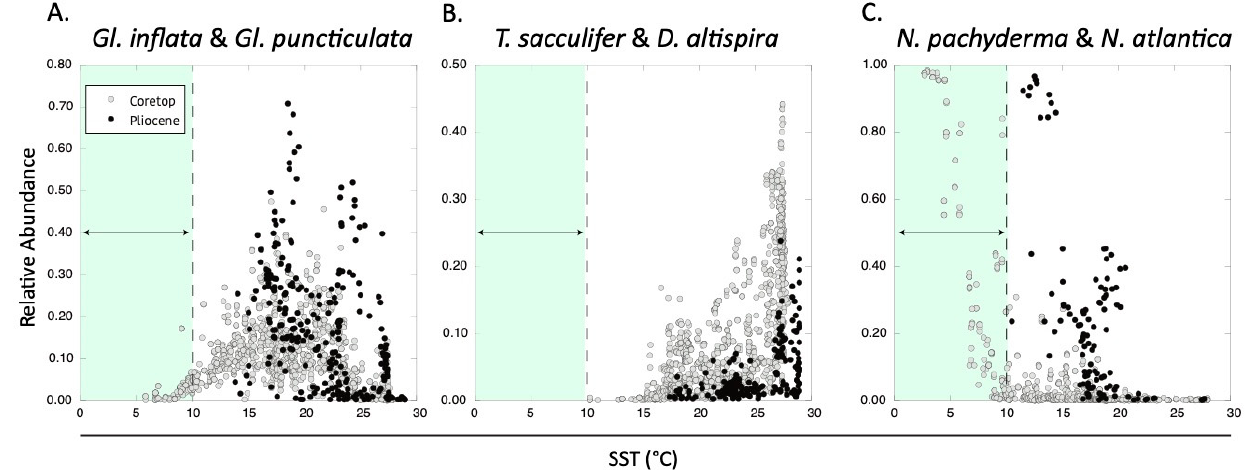
Figure 4. Assessment of previous taxonomic groupings of extinct planktic foraminifera taxa. ( A ) Globoconella inflata (core top) and Globoconella puncticulata (Pliocene), ( B ) Trilobatus sacculifer (core top) and Dentoglobigerina altispira (Pliocene), ( C ) Neogloboquadrina pachyderma (core top) and Neogloboquadrina atlantica (Pliocene). Pliocene data (black); core-top data (gray). Dashed vertical lines at 10 ◦ C indicate the lower temperature limit of Pliocene North Atlantic data. Horizontal arrows and green shading highlight the 0 ◦ C to 10 ◦ C region of only core-top data in each plot.